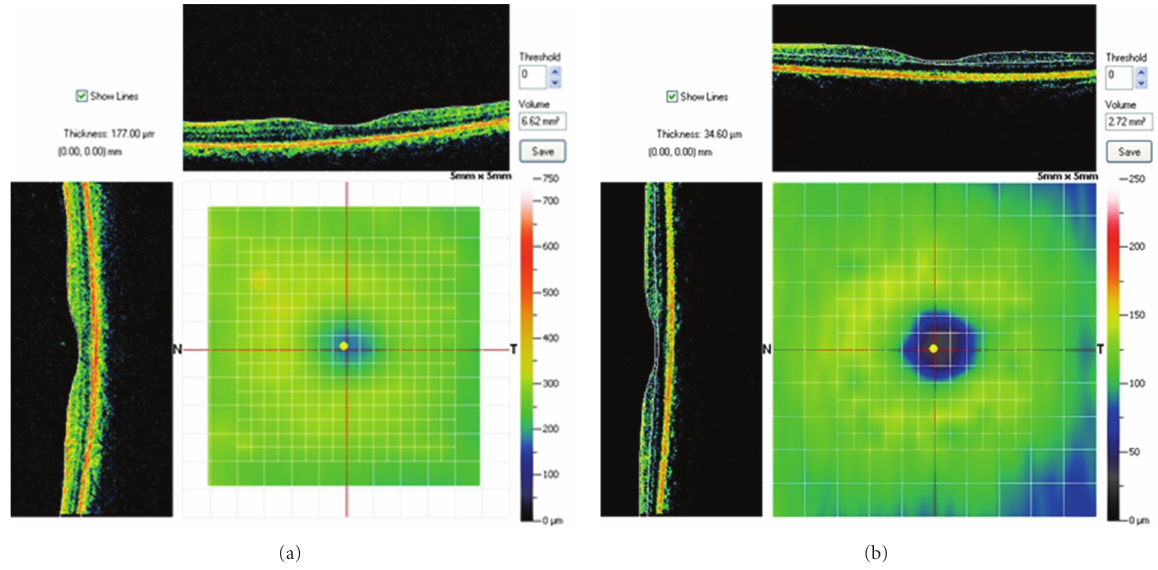
Figure 1: The central yellow dot in this illustration represents fixation at the foveola. The measuring grid visible in the background is centered on the foveola. Thicknesses at each of the intersecting points of the grid and calculated the volume of each 0.25 × 0.25mm voxel. (a) shows the SD-OCT profiles through the fovea for a control subject and (b) SD-OCT profile for a PD